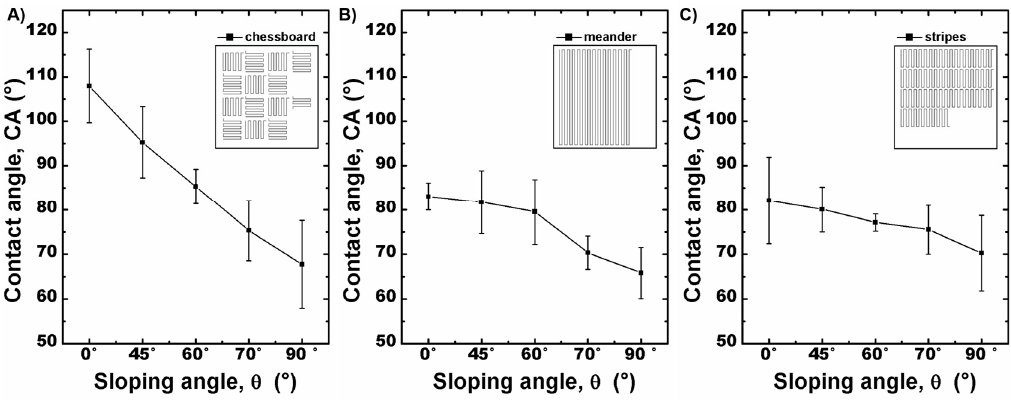
Figure 7. Contact angle measurements results with different scanning strategies and sloping angles: ( A ) chessboard, ( B ) meander and ( C ) stripes.